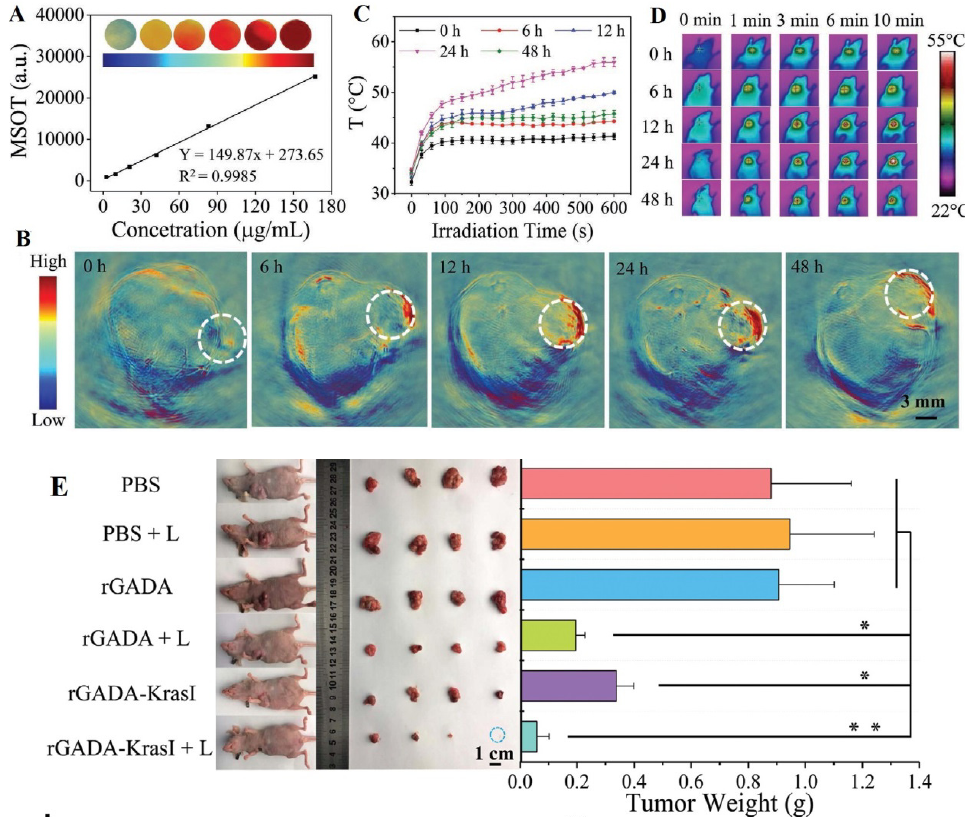
Figure 9. PAI and PT images of rGADA with different concentration and, at different time after intravenous injection to mice containing Capan-1 tumor and, PT and gene therapies with RGADA-KrasI. ( A , B ) are for PAI images of samples and in mice. The white circles represent the tumor region. ( C , D ) are temperature curves of tumor with different irradiation times (0–48 h) and thermographic images from in vivo tumor site at the irradiation time of 10 min with 808 nm laser with 1.2 W/cm 2 power densities. ( E ) Tumor bearing mice and its weights before and after laser treatment with PBS-L, rGADA + L, and rGADA-KrasI + L. The stars (*) represents the statistical significance of the data (* for 0.05, ** for 0.01). Reprinted/adapted with permission from Ref. [132]. Copy right 2020, copyright Wiley-VCH .